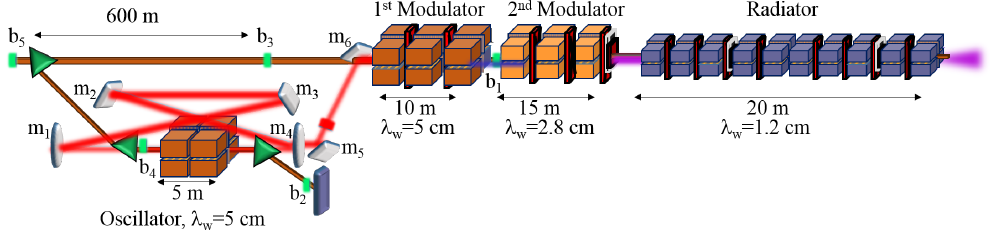
Figure 4. Segmented undulator scheme for a three-stage cascade driven by an Extreme Ultraviolet-FEL Oscillator.